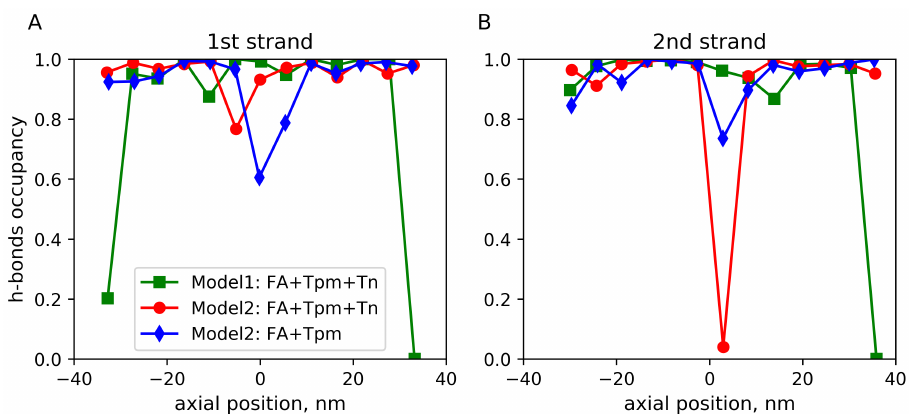
Figure 5. The relative lifetime of h-bonds between actin residues Lys326 or Lys328 of the long actin helices 1 ( A ) and 2 ( B ) and conserved acid Tpm residues of the corresponding strands 1 or 2 shown along the filament axis. Color code is the same as in Figure